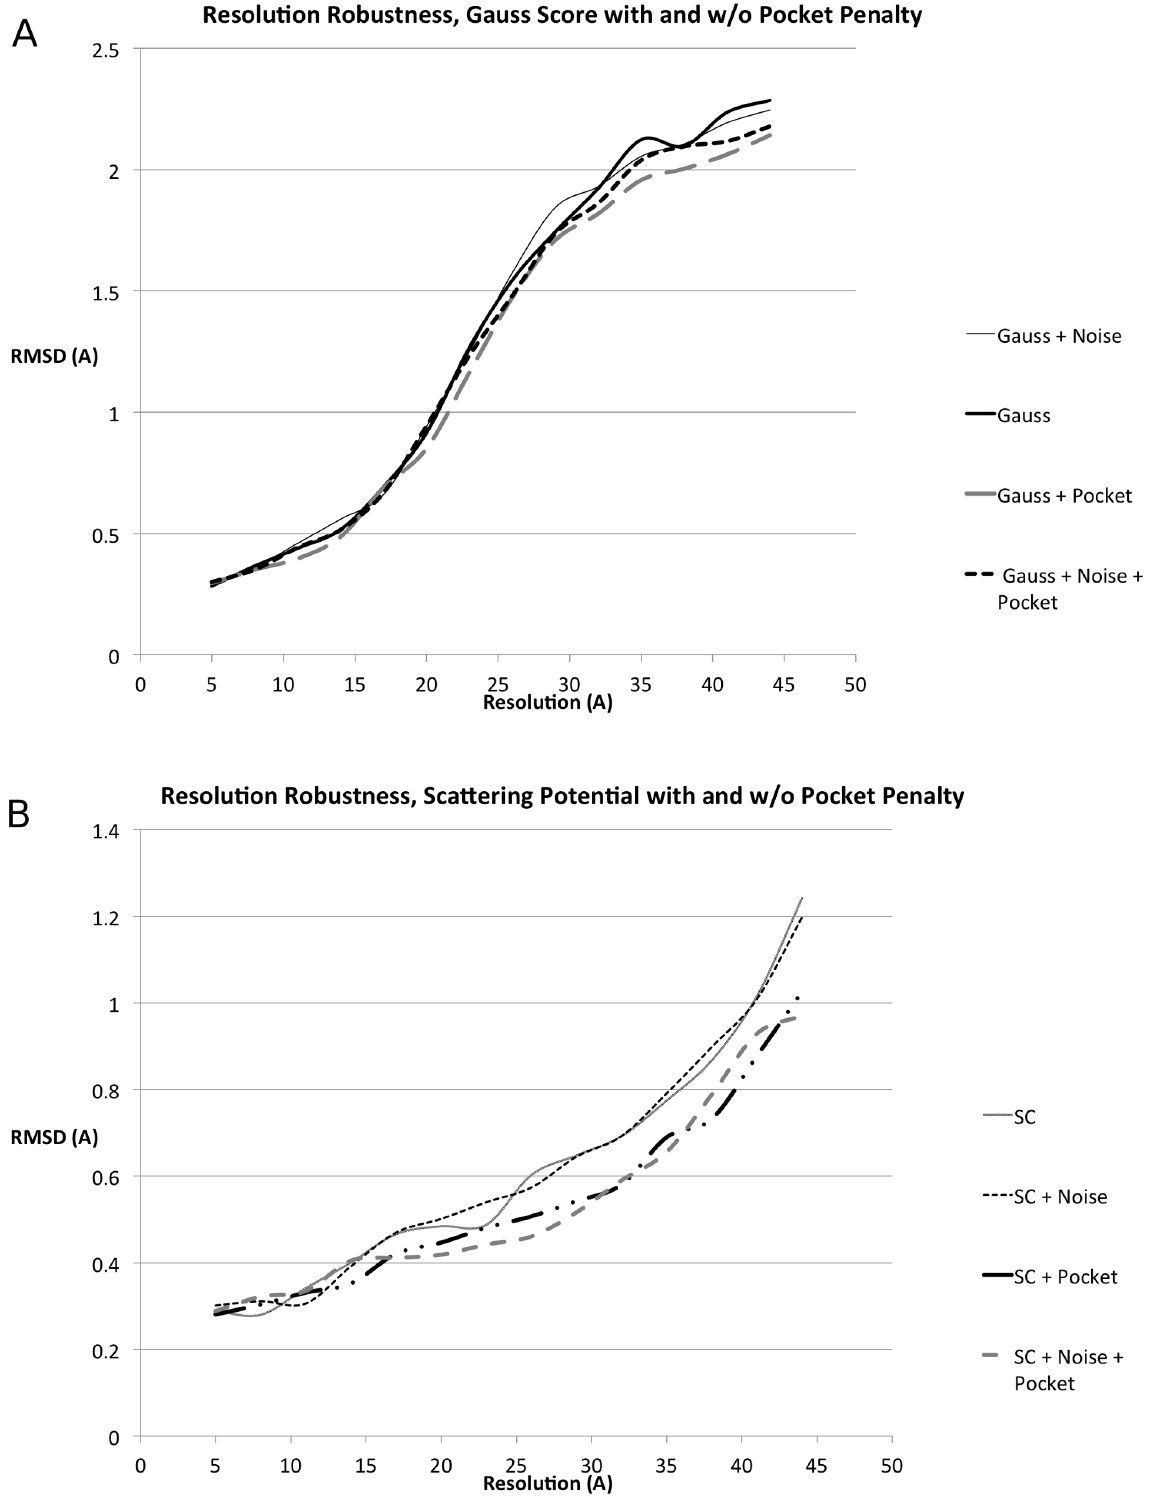
Fig 6. Effect of complementary space scoring for synthesized data. Using the complementary space scores from (A) Eq (8) and (B) Eq (9), with w comp = 1, w target = 1 we plot the RMSD as a function of the resolution of the EM map. See the section titled “ Dataset ” for a list of PDBs used in this experiment.